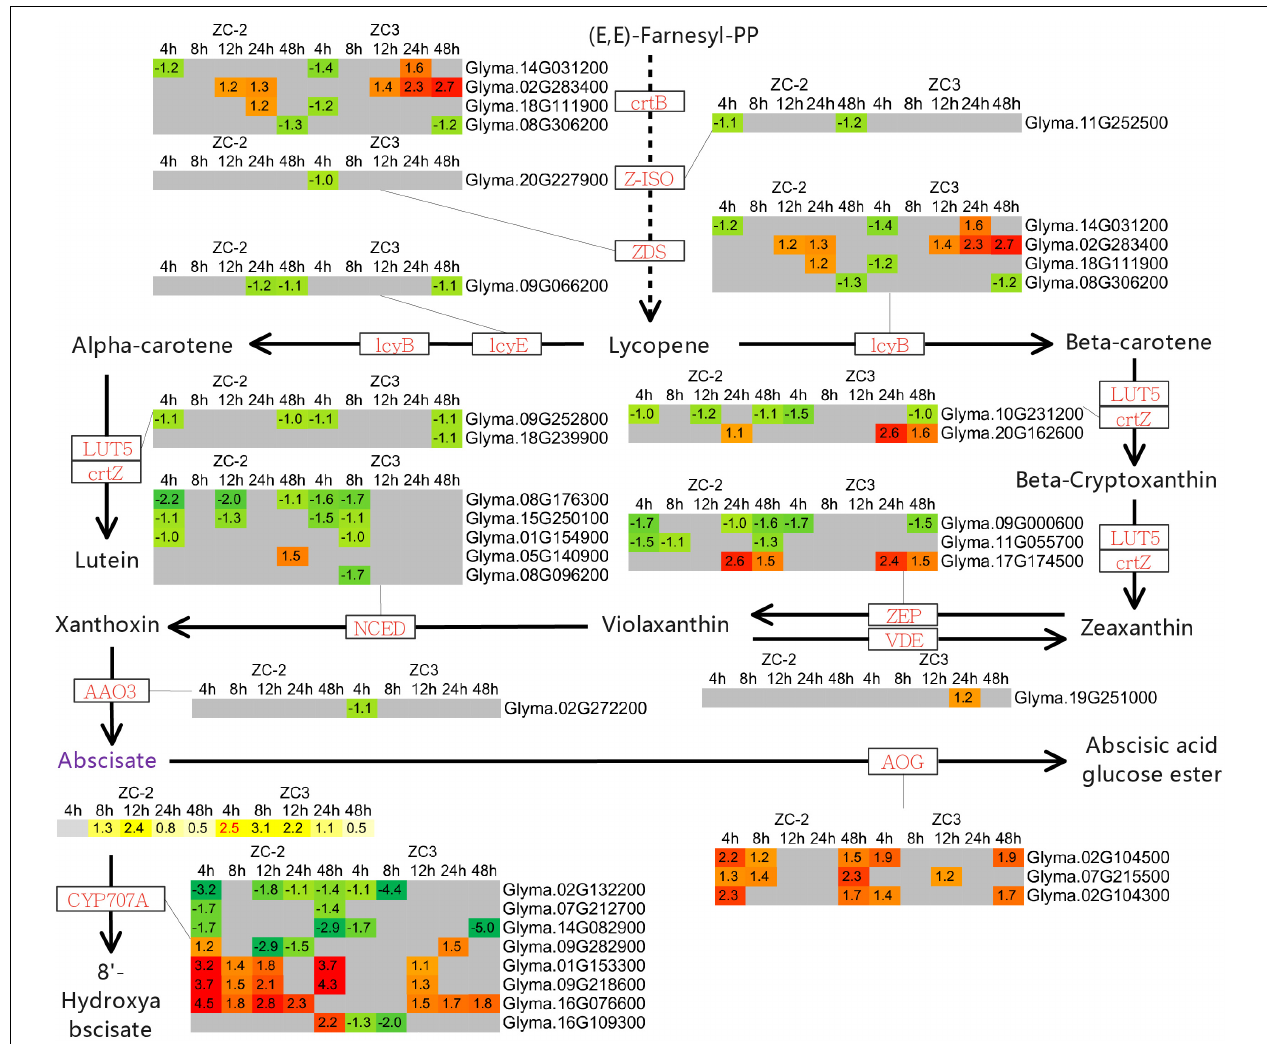
FIGURE 10 | Schematic diagram of carotenoid biosynthesis with heatmaps of the associated differentially expressed genes (DEGs) and differentially accumulated metabolites (DAMs). The log 2 expression fold change is color-coded in each box: red and yellow indicate up-regulated DEGs and DAMs, and green and blue indicate down-regulated DEGs and DAMs, respectively. Each row represents a DEG or DAM; the columns represent each sampling time point [4, 8, 12, 24, and 48 h post-inoculation (HPI)] for ZC-2 and ZC3. Abbreviations for DEGs are in red font and those for DAMs are in purple